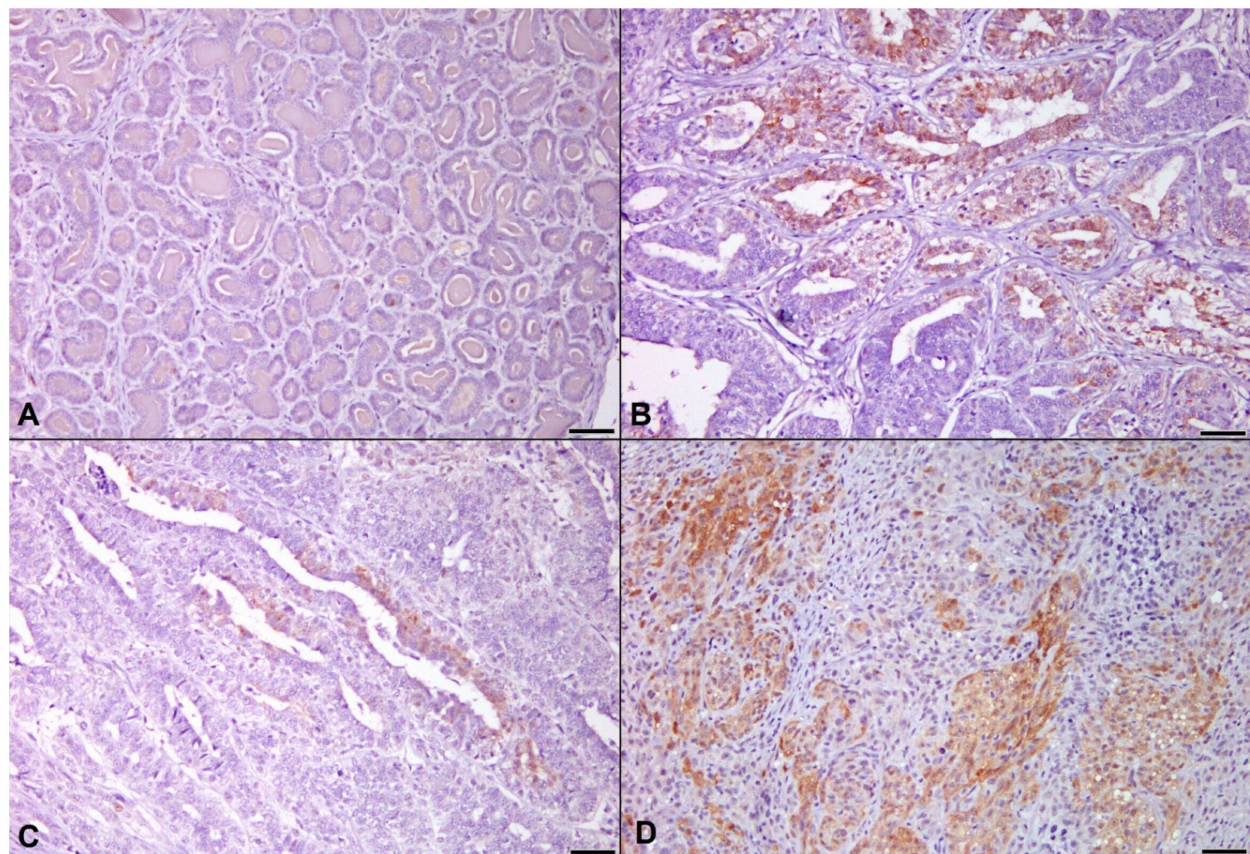
Figure 3. Immunohistochemistry for p-Akt. ( A ) Mammary gland hyperplasia. Expression of p-Akt was barely detected. ( B ) Mammary adenoma. p-Akt was found in both the nucleus and cytoplasm of neoplastic epithelial cells. ( C ) Mammary carcinoma, low-grade. Higher expression of p-Akt was observed than in normal mammary gland. ( D ) Mammary carcinoma, high-grade. Intense positive staining for p-Akt was shown in many neoplastic epithelial cells, indirectly showing the increased Akt activity in more malignant tumors. Immunohistochemistry, counterstained with 100% Gill’s hematoxylin. Original magnification 200 × . Bar = 50 µ